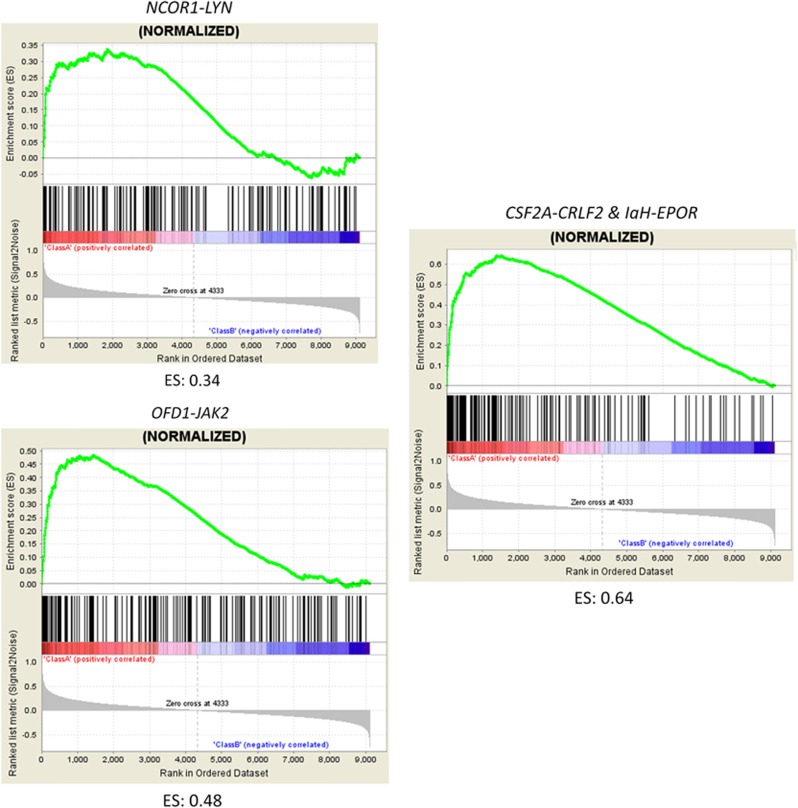
Gene set enrichment analysis plot of the patients with NCOR1-LYN, OFD1-JAK2 and CSF2RA-CRLF2. The enrichment score (ES) is shown at the bottom of each graph. The positive ES means significant enrichment of the BCR-ABL1 gene expression signature.